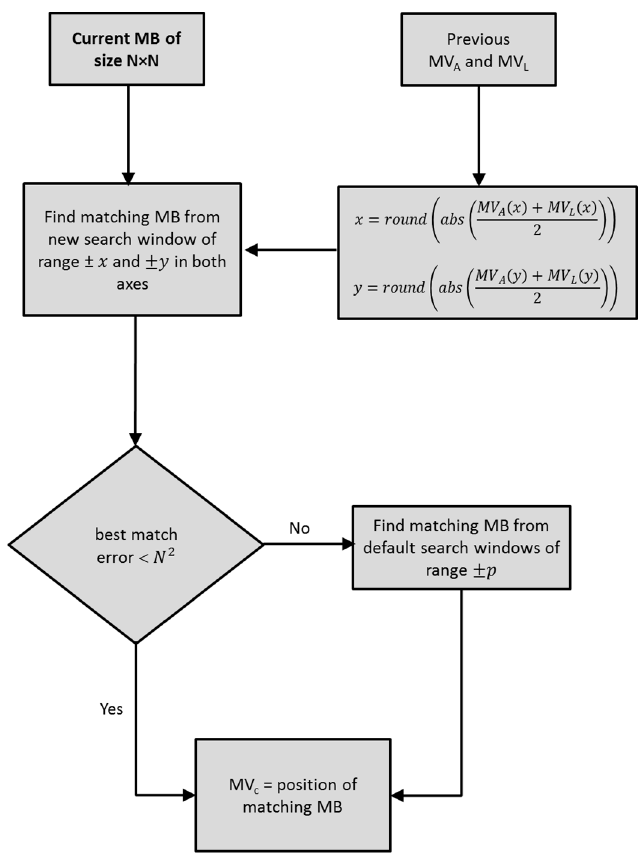
Figure 3. Schematic of the novel mean predictive block matching algorithms for lossless compression (MPBMLS) in calculating the motion vector of the current MB.